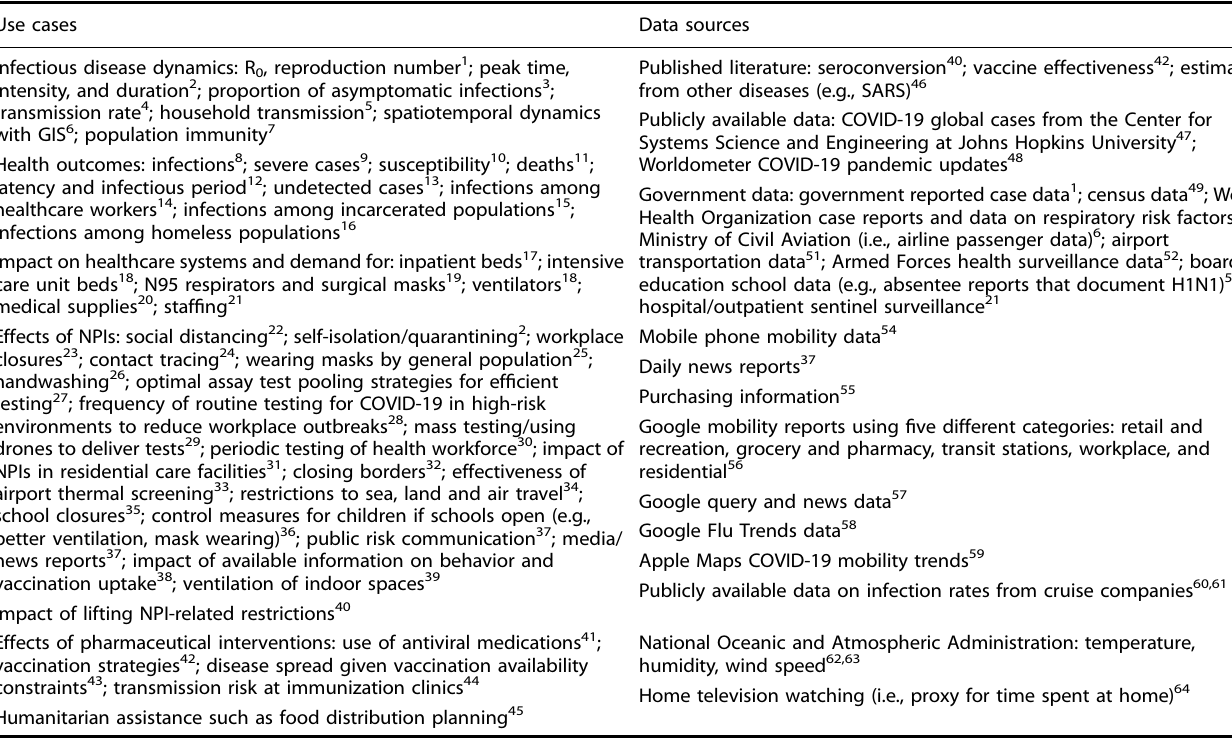
Table 2. Areas where machine learning could be leveraged for improving the accuracy of estimations or projections and potential data sources identi fi ed through the review of traditional approaches. Use cases